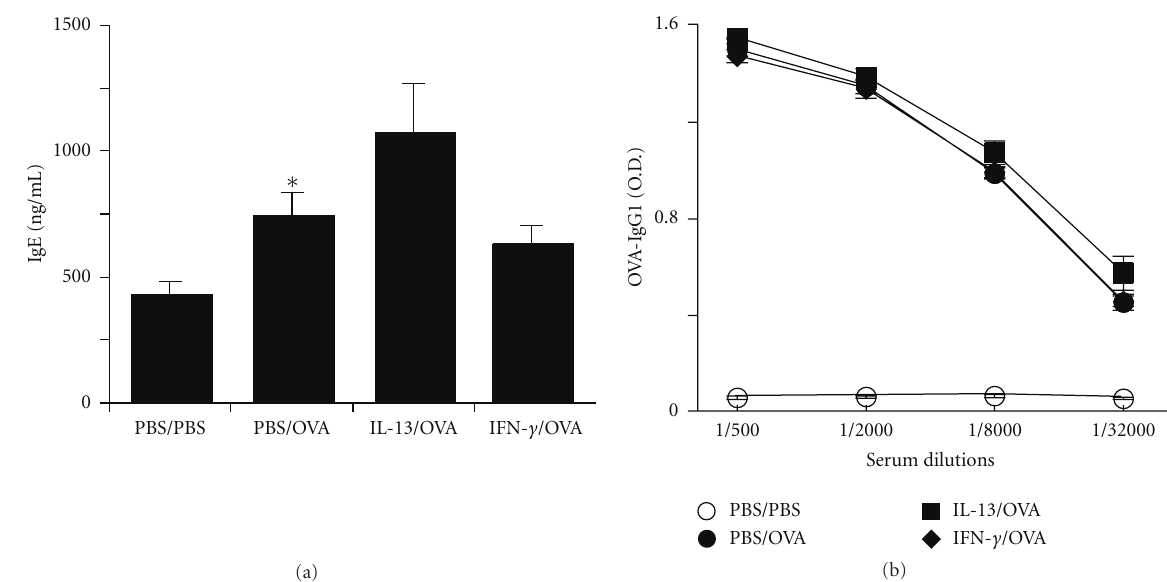
Figure 4: E ff ects of IL-13 and IFN- γ on serum Ig levels. Levels of IgE (a) and OVA-specific IgG1 (b) in serum from PBS/PBS, PBS/OVA, IL-13/OVA and IFN- γ /OVA groups of mice. ∗ P -value ≤ . 05 versus